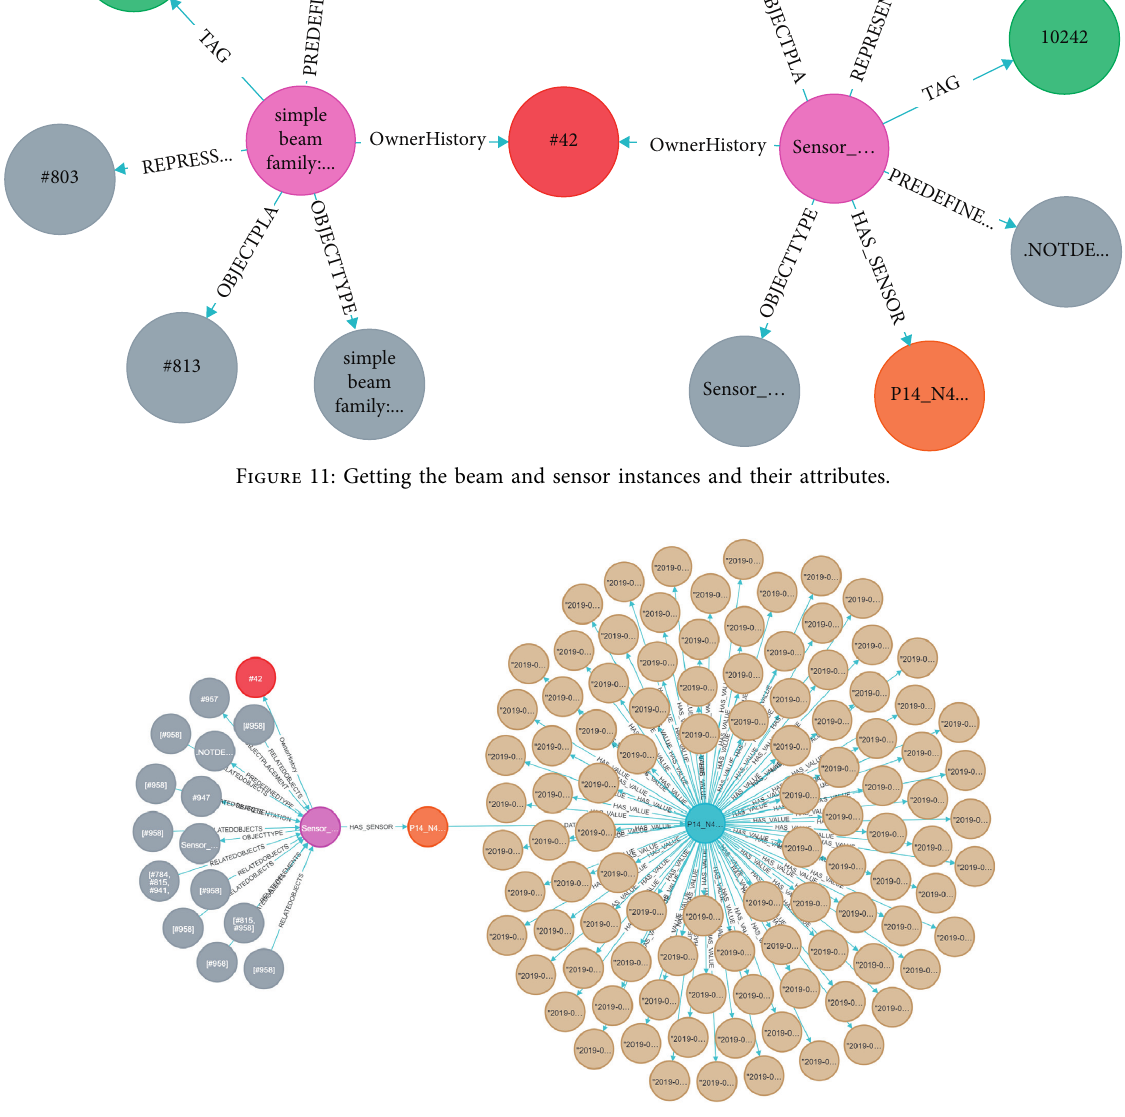
Figure 12: Retrieval of the sensor element and data for a certain